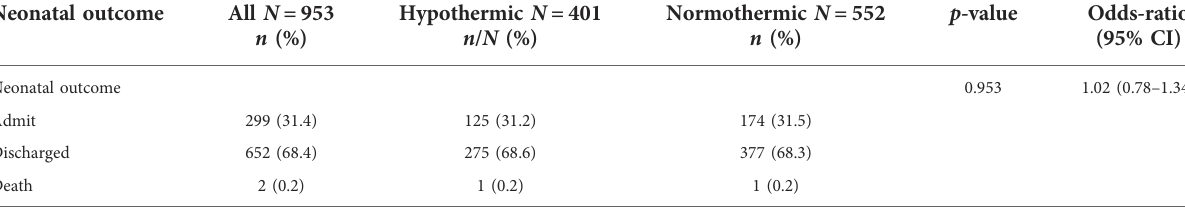
TABLE 7 Neonatal outcomes among study participants.